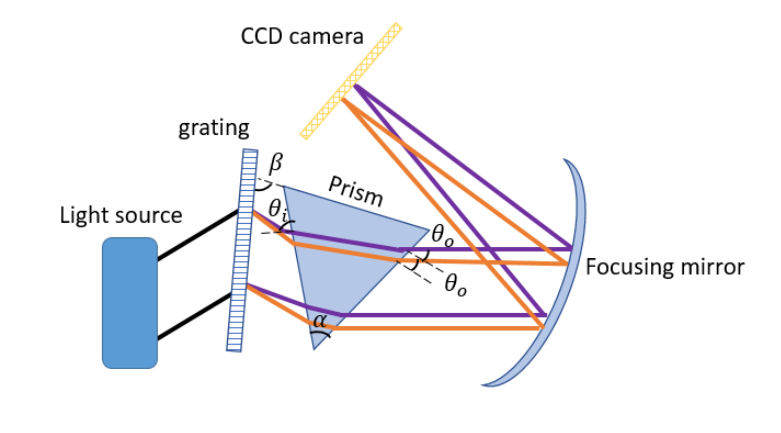
Figure 2. Schematic of the spectrometer using grating and prism (two wavelengths, orange longer and purple shorter).